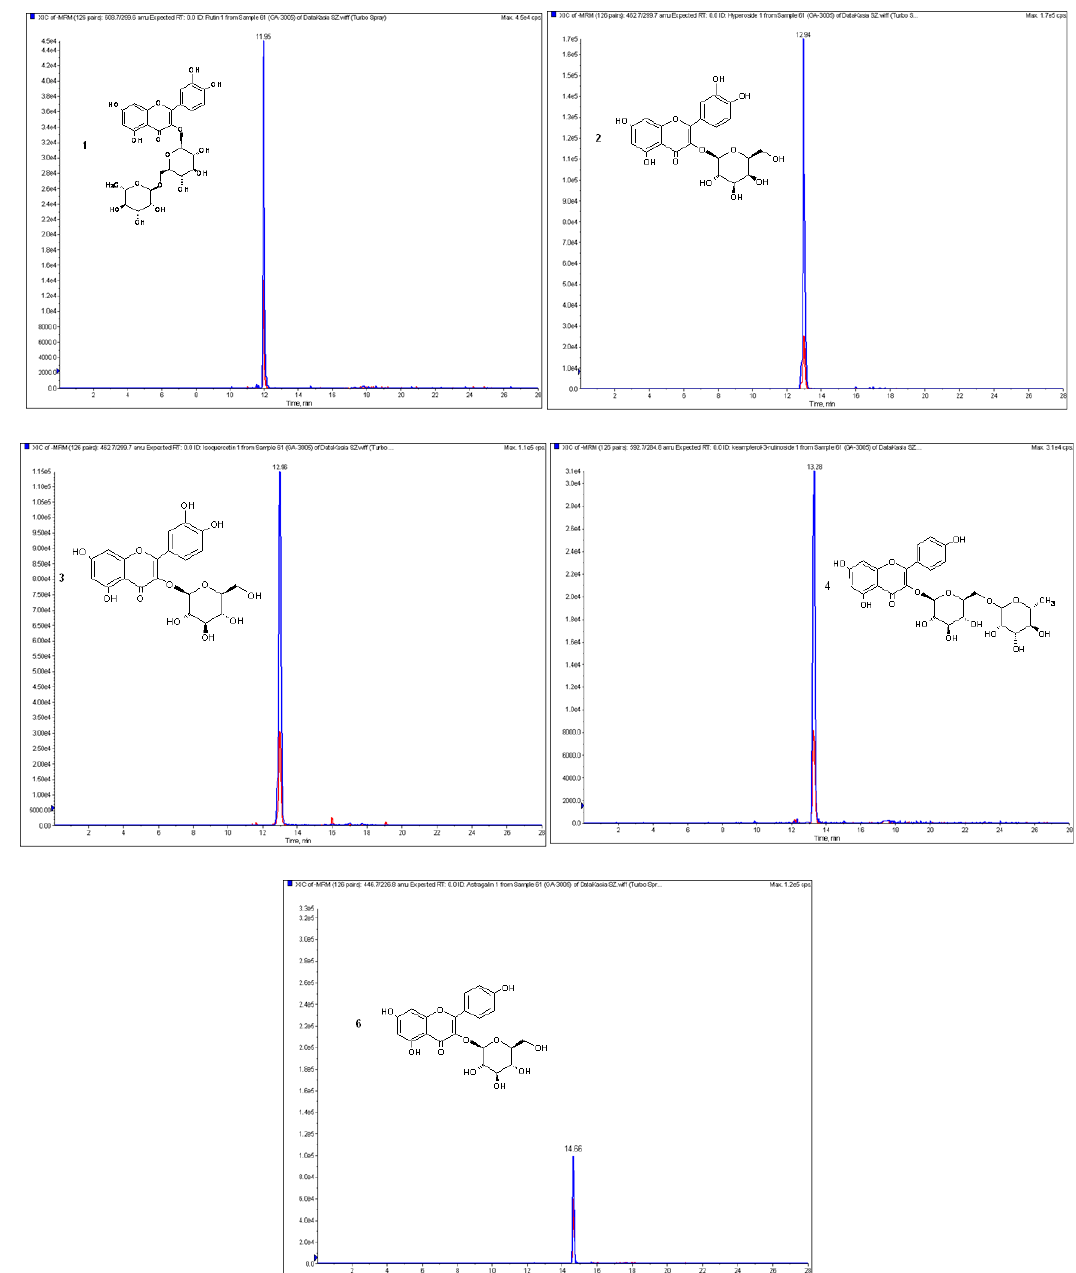
Figure 2. The chromatogram in MRM of flavonoid glycosides occurring in the methanolic extract of L. krapffii fruits: 1-rutin; 2-hyperoside; 3-isoquercetin; 4-kaempferol-3- O -rutinoside; 6-astragalin.